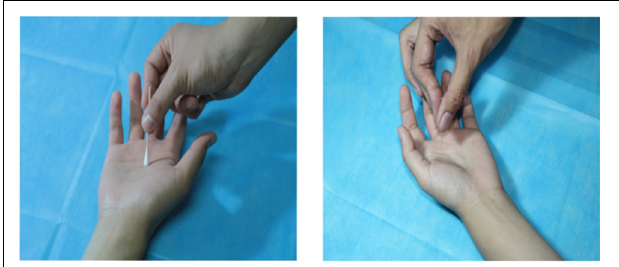
FIGURE 1 | Stimuli examples. Illustration of the stimuli used in the current study. The left picture shows swab contact, and the right picture shows